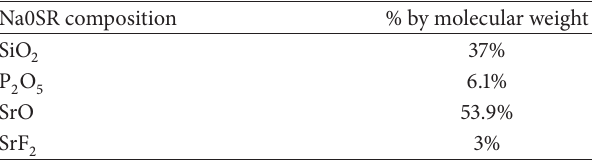
Table 1: Composition of Na0SR by molecular weight